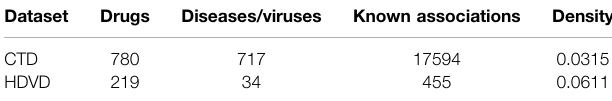
TABLE 1 | Statistics of pre-processed CTD and HDVD database.